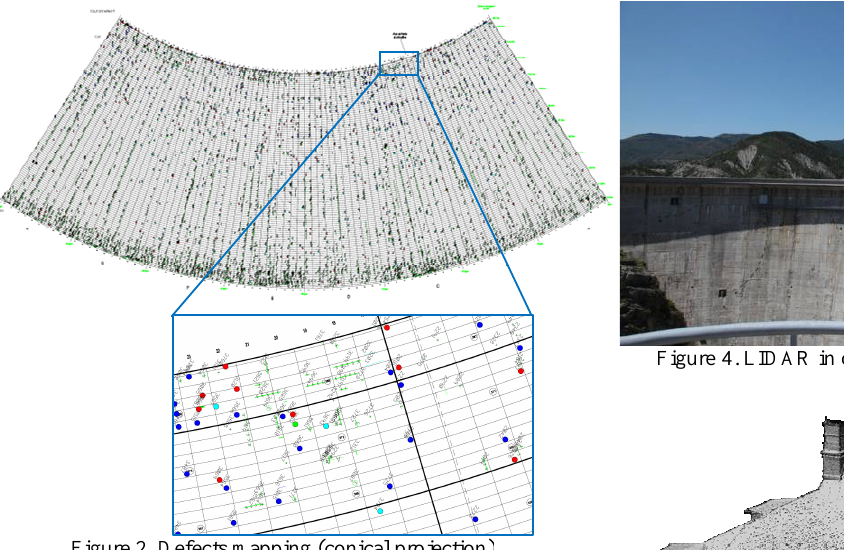
Figure 2. Defects mapping (conical projection)